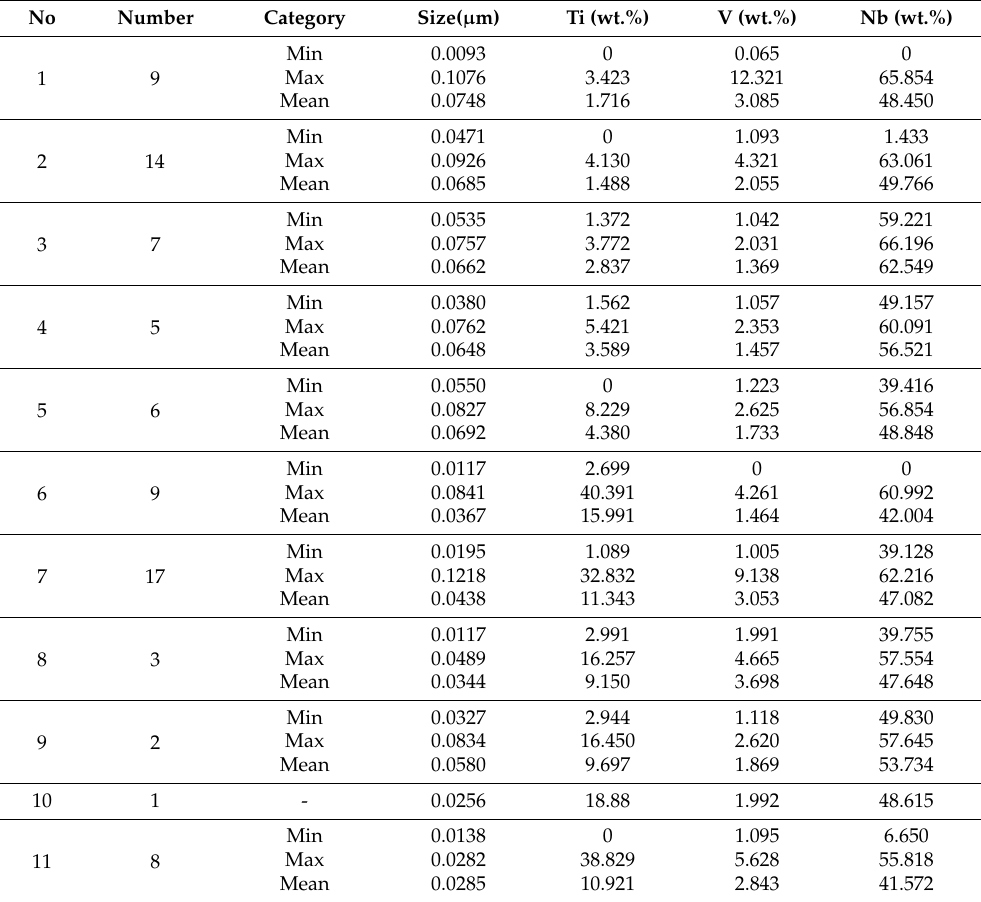
Table 4. Statistical analyses of the size and composition of precipitates in steel